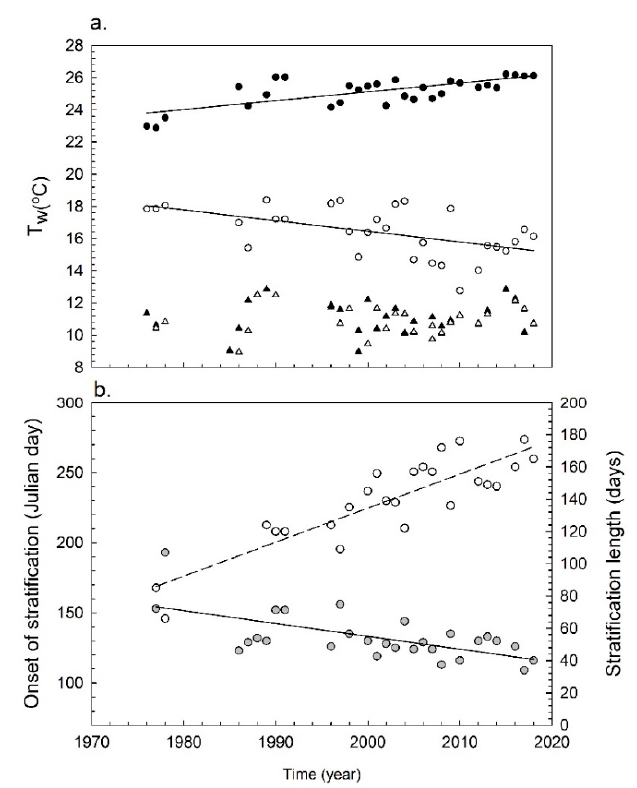
Figure 3. Temporal evolution of the water temperature for the surface layer at z = 0.5 m (solid circles) and for the hypolimnion, at z = 20 m, (open circles) for the July, August and September (JAS) period. Solid triangles and open triangles correspond to the December, January and February (DJF) period ( a ). Temporal evolution of stratification onset (in grey solid symbols) and stratification length in open symbols ( b ).